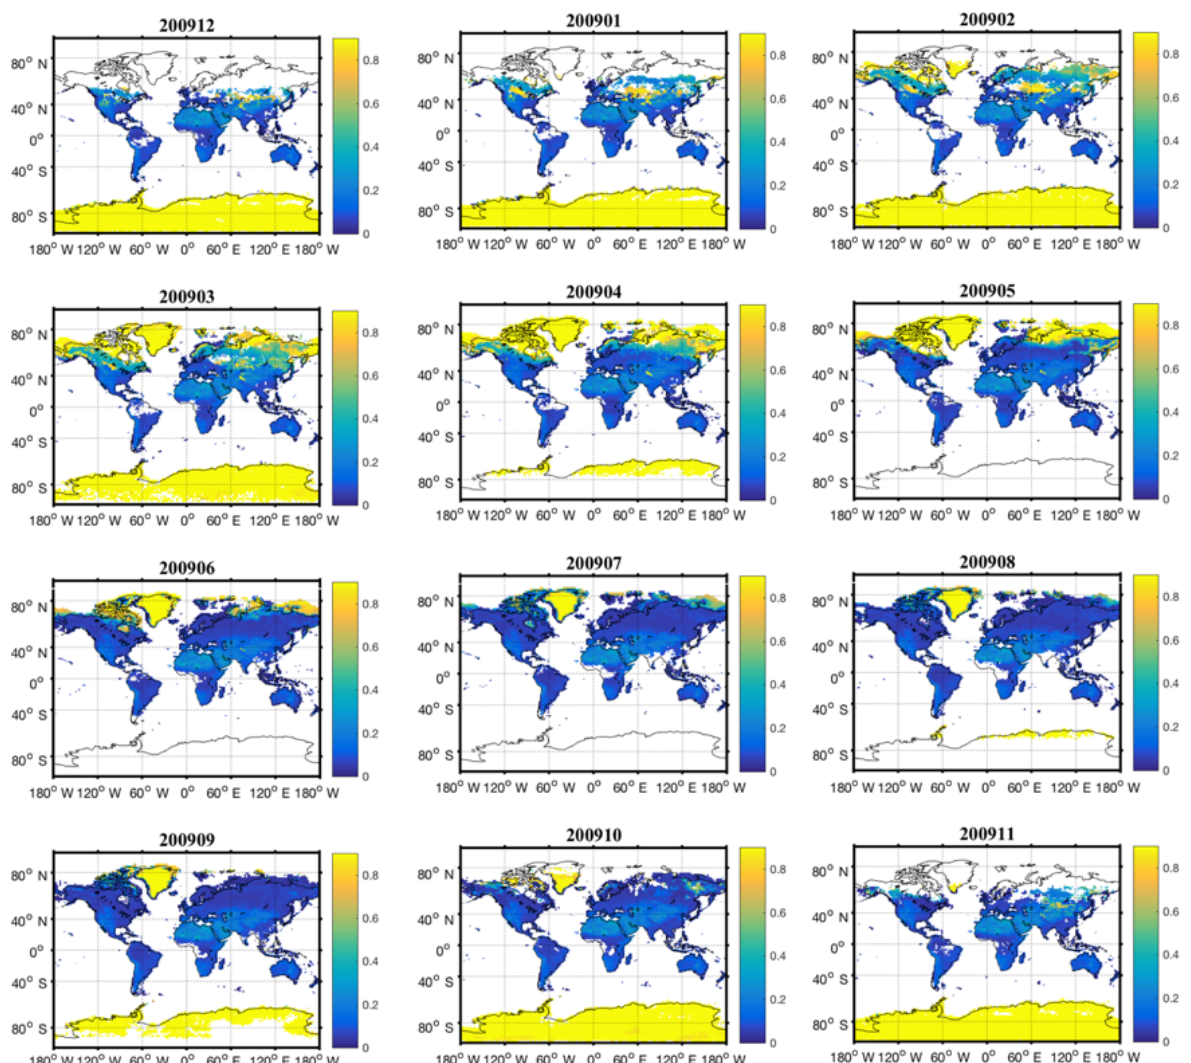
Figure 11. The monthly MODIS surface reflectance at 555nm in 2009. The colors represent the value of surface reflectance. There are no MODIS observations during polar night at high